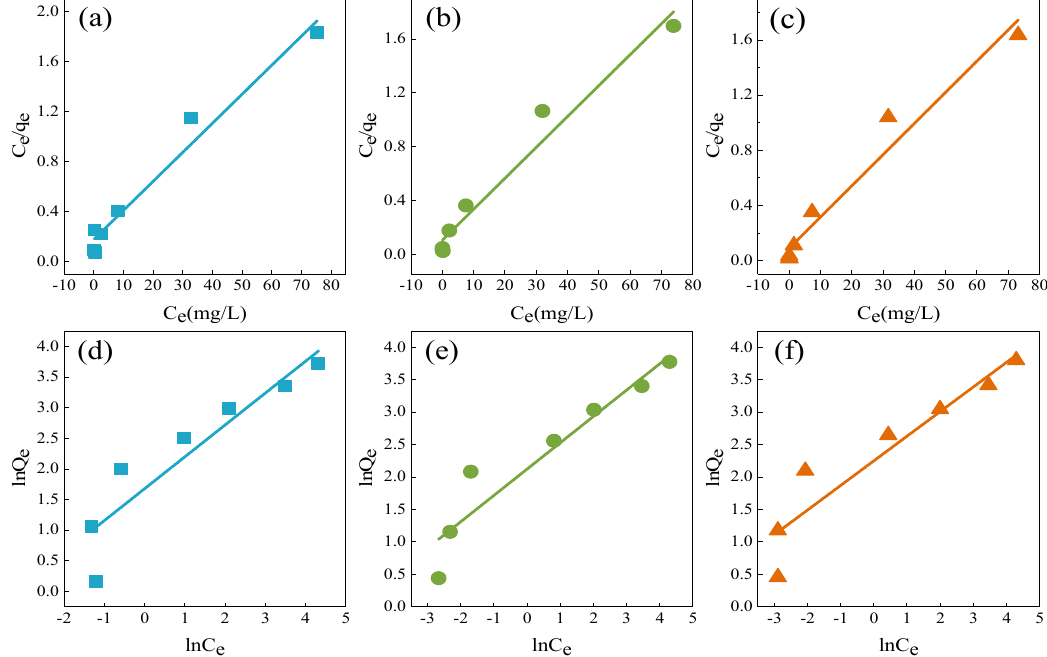
Figure 7. The Langmuir isotherm model curve for Mxene–CS ( a – c ) and the Freundlich isotherm model curve ( d – f ). Table 2. The parameters and correlation coefficients for the Langmuir and Freundlich isotherm model. Langmuir Parameters Freundlich Parameters T(K) q max (mg/g) 298 43.10